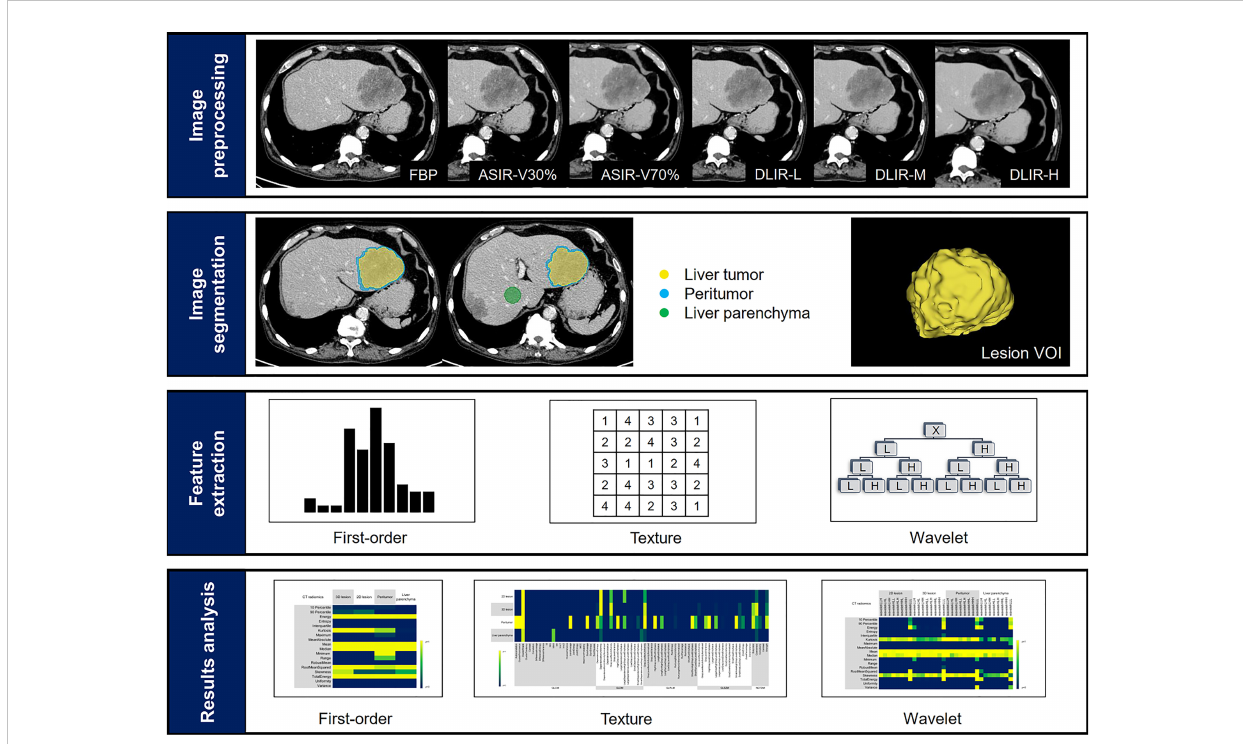
FIGURE 2 Study work fl ow. The work fl ow presented a summary of image reconstruction, target lesions annotation and dilation, feature extraction and results